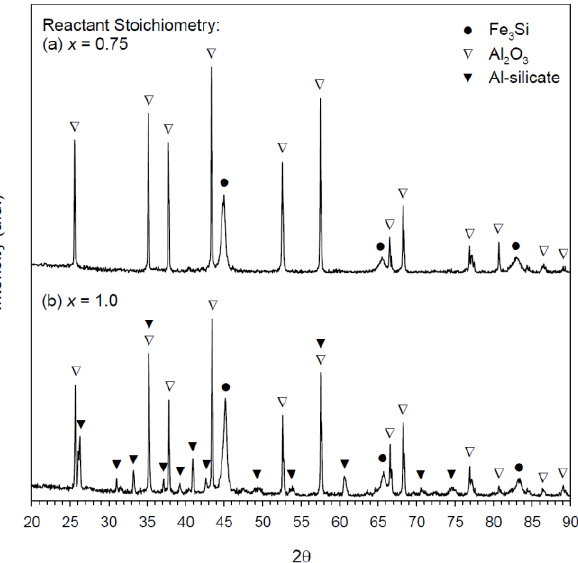
Figure 4. XRD patterns of Fe 3 Si-Al 2 O 3 composites synthesized from Reaction (1) with ( a ) x = 0.75 and ( b ) x =